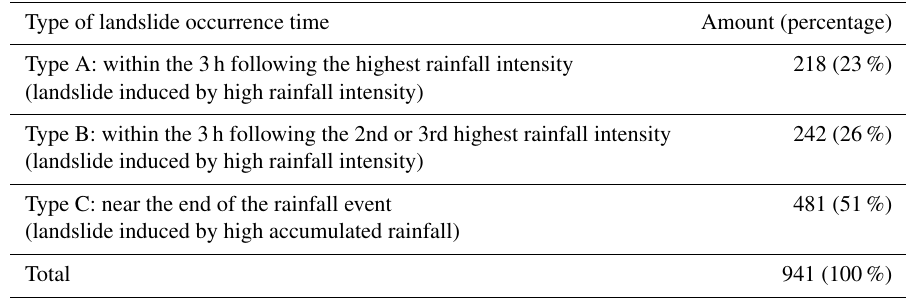
Table 3. Type and the proportion of landslide occurrence times.